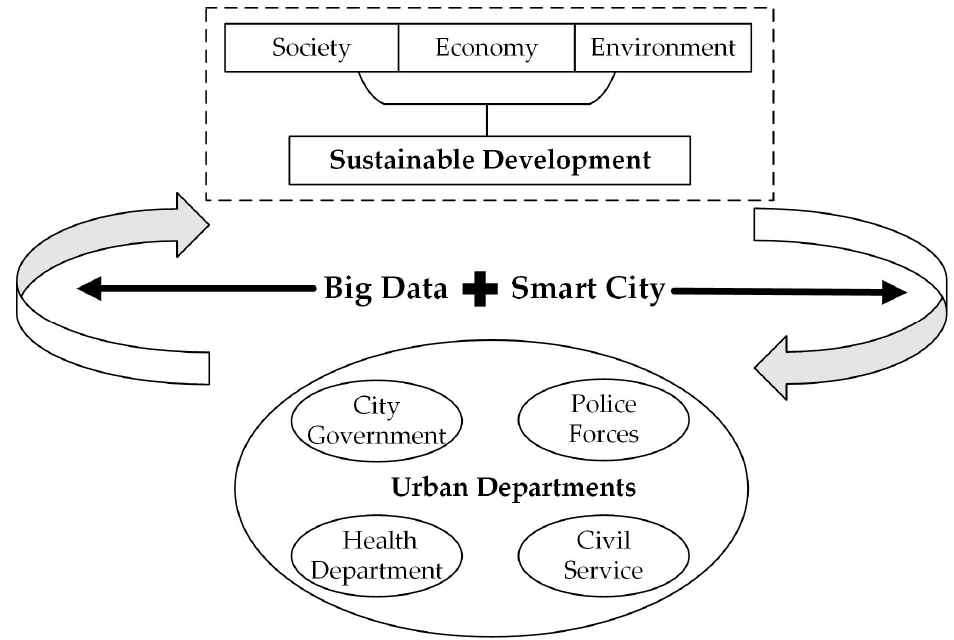
Figure 3. Big Data and Smart City for Sustainable Development.